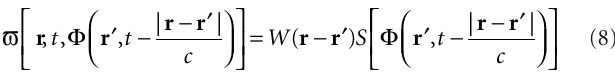
Figure 5 | Power spectrum of neural activity before (blue) and during (red) stimulation. Before closed-loop stimulation, the dominant frequency is 10 Hz. During closed-loop stimulation specifically targeting the 10 Hz frequency, the power spectrum is strongly decreased at 10 Hz (and also at its sub-harmonics) whereas